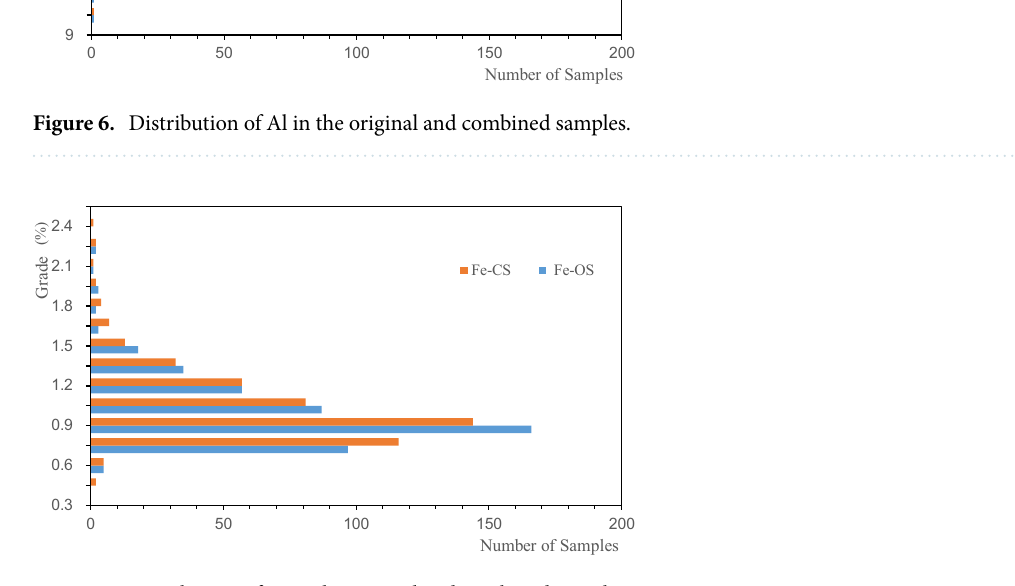
Figure 7. Distribution of Fe in the original and combined